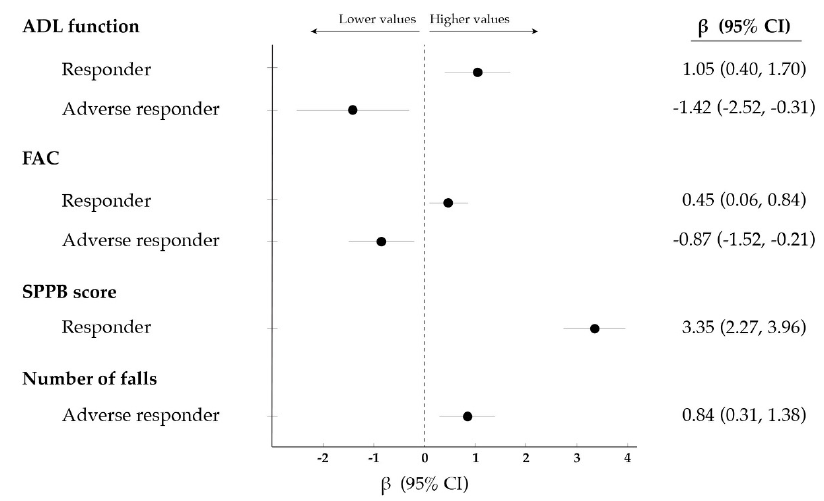
Figure 2. Significant ( p < 0.05) association between: (i) the response of functional ability (i.e., ability to perform activities of daily living [ADL] independently) to the exercise intervention (i.e., responder, non-responder or adverse responder to exercise (i.e., responder [improvement], non-responder [no change] or adverse responder [decrease]); and (ii) di ff erent outcomes at discharge or during a 3-month follow-up. Data were analysed using linear regression and are expressed as β along with 95% confidence intervals (CI). No significant associations were found for non-responders. Abbreviations: FAC, functional ambulatory category; SPPB, short physical performance battery.